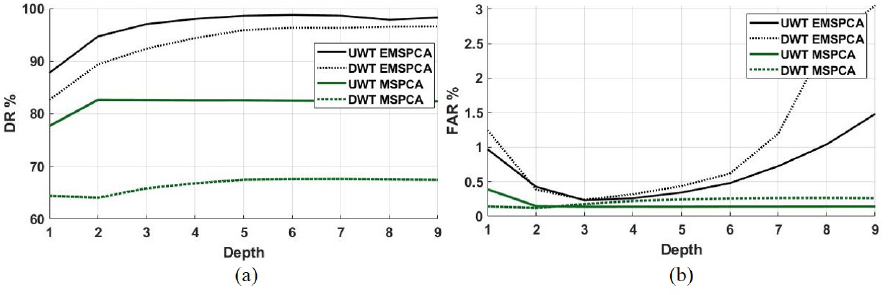
Figure 12. DR ( a ) and FAR ( b ) for decimated (DWT) and undecimated (UWT) EMSPCA with a fault size of 1 sigma.